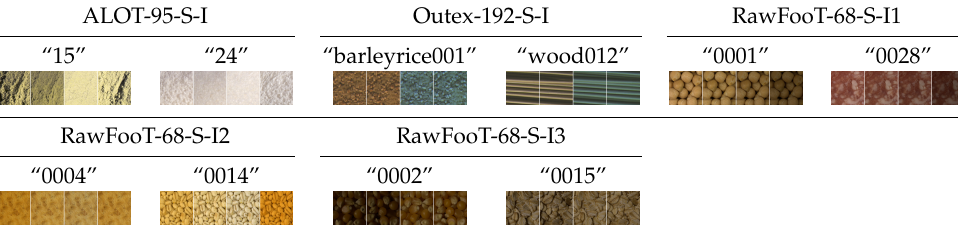
Figure 3. Group #3: Stationary textures acquired under variable illumination (Section